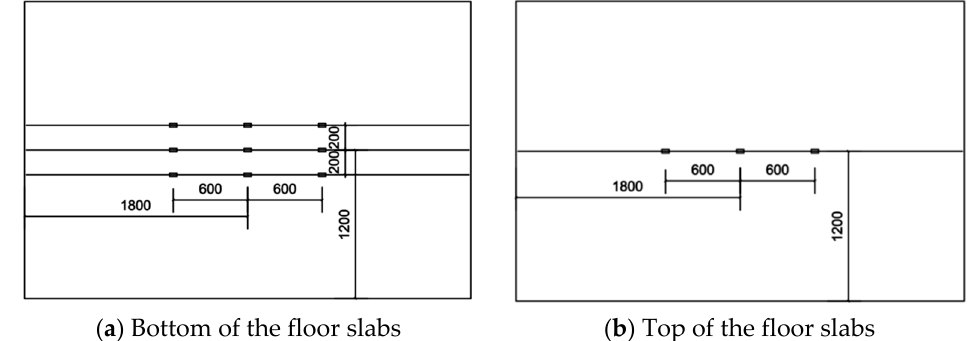
Figure 9. Layout of measurement points for reinforcement strain gauges (unit: mm).